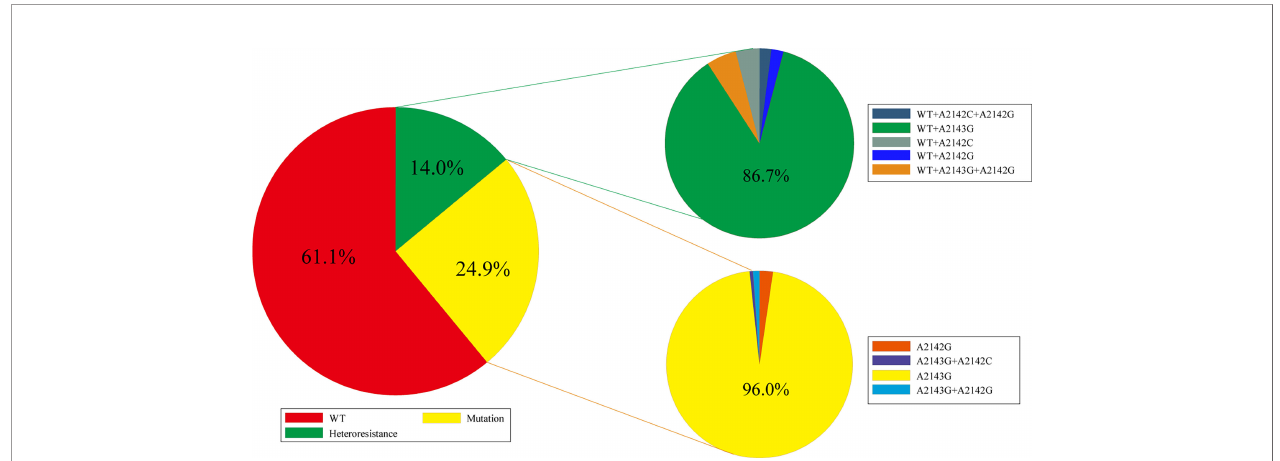
FIGURE 1 | Pro fi le of 23S rRNA genotyping in gastric biopsies (WT, wild type; A2142G, A2143G, and A2142C are point mutations in 23S rRNA